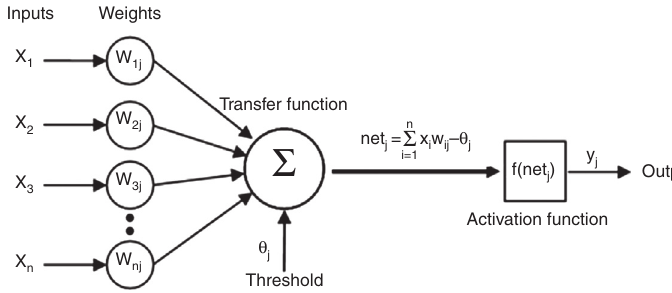
Figure 2 Artificial neural cell (artificial neuron).